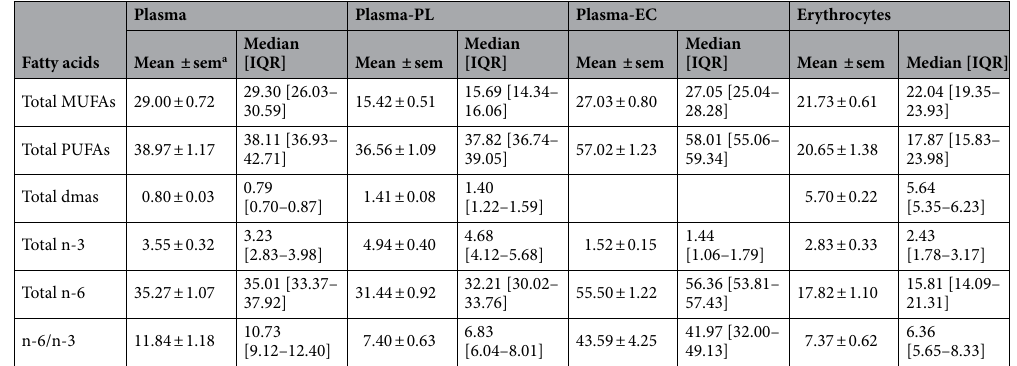
Table 3. Fatty acid composition of total lipids from erythrocytes, plasma, plasma phospholipids, and plasma ester cholesterol (% of total fatty acids). IQR interquartile range (Q1–Q3), AA arachidonic acid, ALA α-linolenic acid, DHA docosahexaenoic acid, dmas dimethyl acetals, DPA docosapentaenoic acid, EC ester cholesterol, LA linoleic acid, MUFAs monounsaturated fatty acids, PL phospholipid, PUFAs polyunsaturated fatty acids, SFAs saturated fatty acids. a n = 23 subjects.